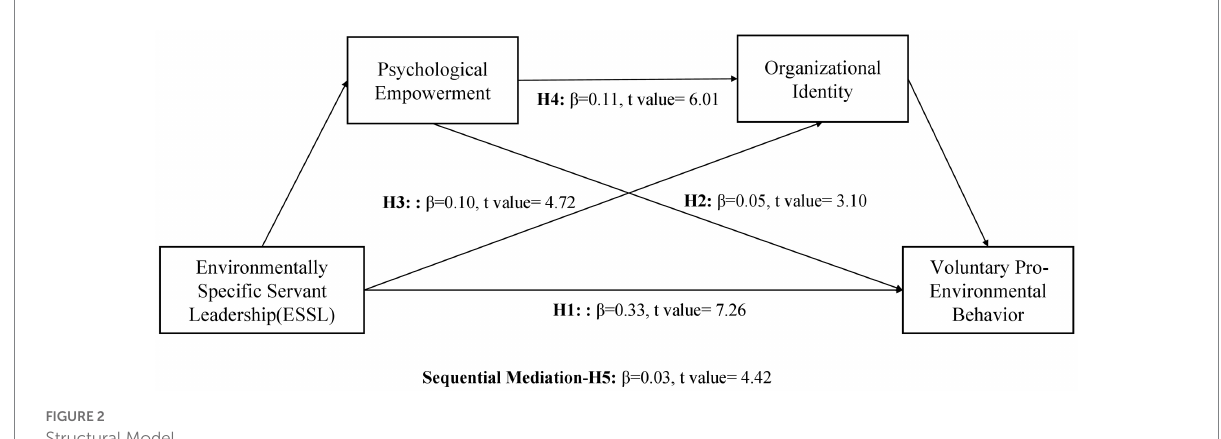
FIGURE 2 Structural